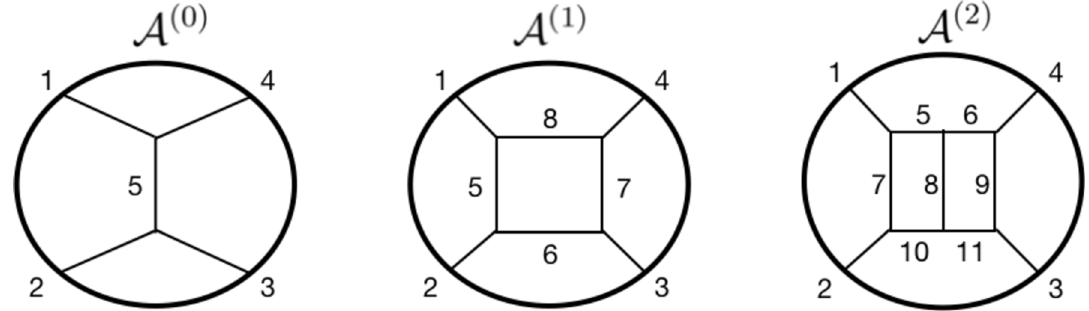
Figure 5 . 4-point ladder diagrams. Left: the tree-level exchange diagram is the 0-loop ladder. Middle: the box diagram is the 1-loop ladder diagram. Right: the 2-loop ladder